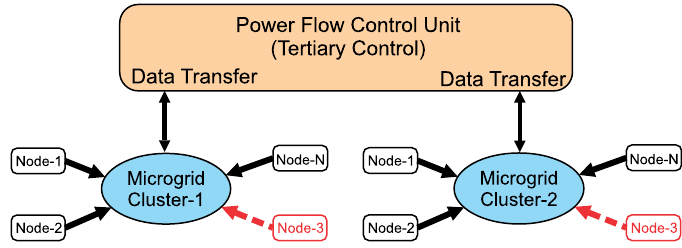
Figure 36. Tertiary